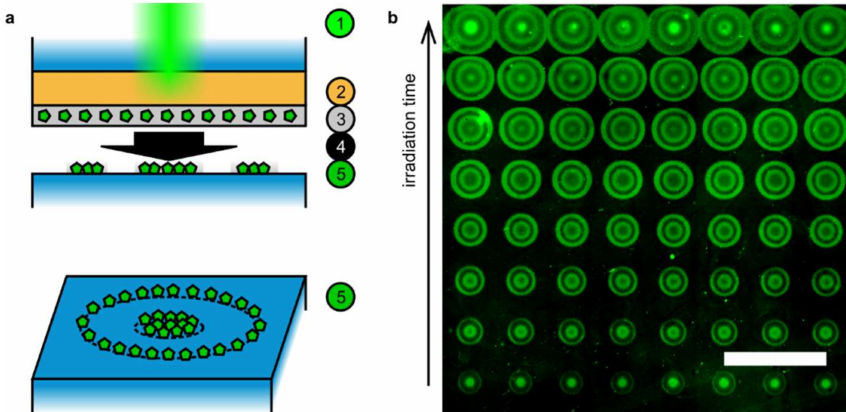
Figure 1. Experimental scheme: ( a ) A focused laser beam (1) heated an absorption layer (2) and a coated polymer thin film containing the compounds to be transferred (3). This generated a micro-jet (4) confined between the two plates, probably by evaporating solvent residues and creating an aerosol. Concentric deposition patterns (5) were observed thereafter on the acceptor slide. ( b ) Image of self-assembled concentric amino acid patterns (fluorescently labeled), as transferred onto the acceptor slide by the laser process. Increasing irradiation time (1, 1.5, 2, 3, 5, 7.5, 10, and 20 ms) resulted in the occurrence of additional concentric rings of the deposited material. The scale bar represents 1 mm. The laser beam diameter was 15 µ